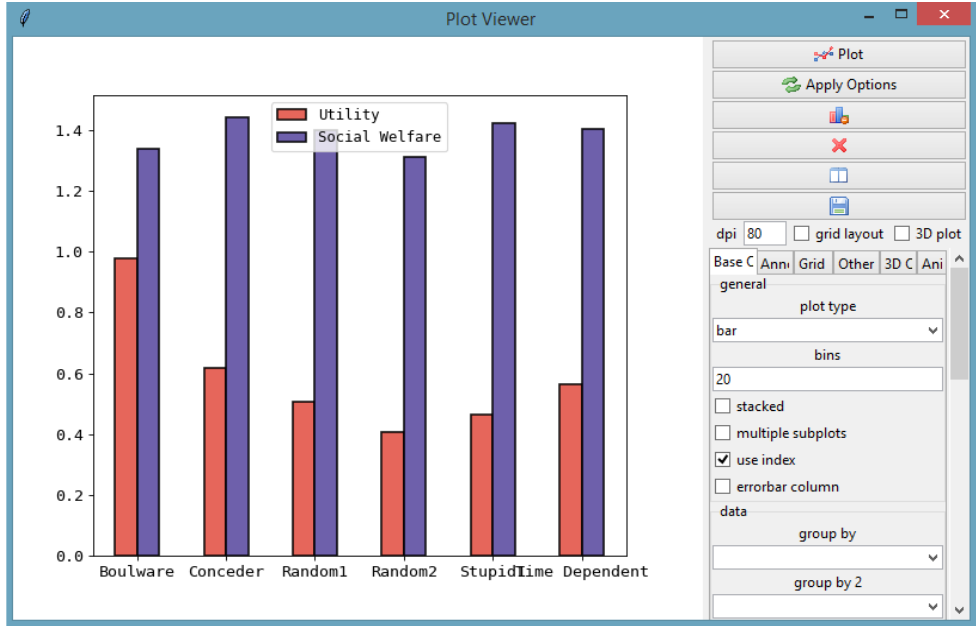
Figure 7. The tournament results table data is shown as a bar chart.